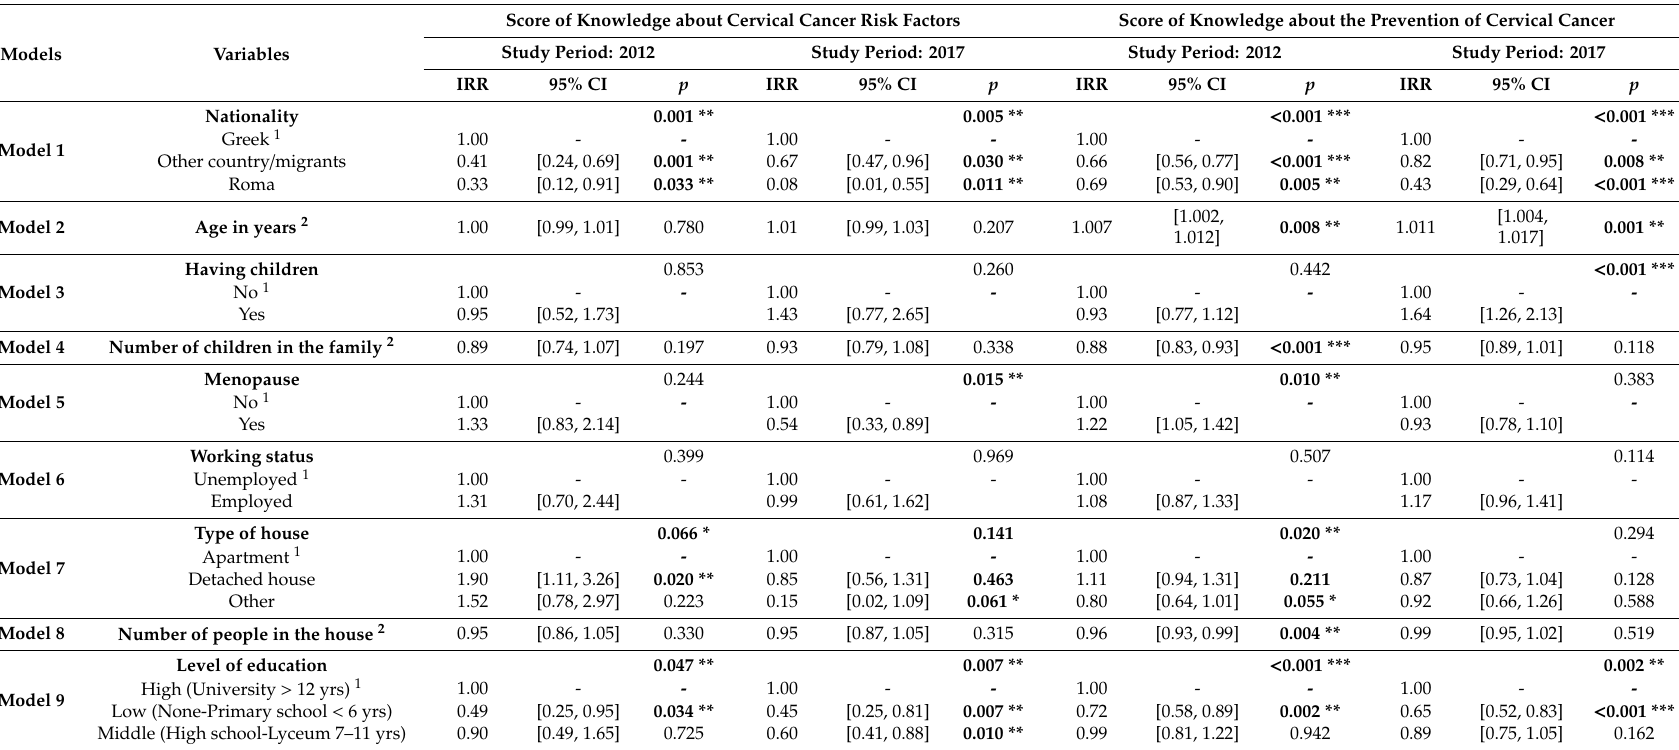
Table 3. Incidence Rate Ratio, 95% Confidence Intervals and the corresponding level of statistical significance concerning the e ff ect of women’s characteristics on the average score regarding their knowledge about the cervical cancer and their knowledge about the prevention of cervical cancer, for each study